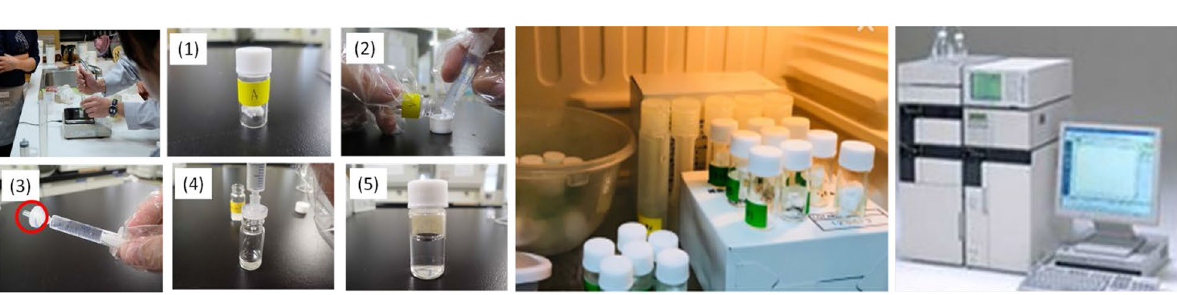
Figure 3. The bacteria culture process and CFUs assessment.